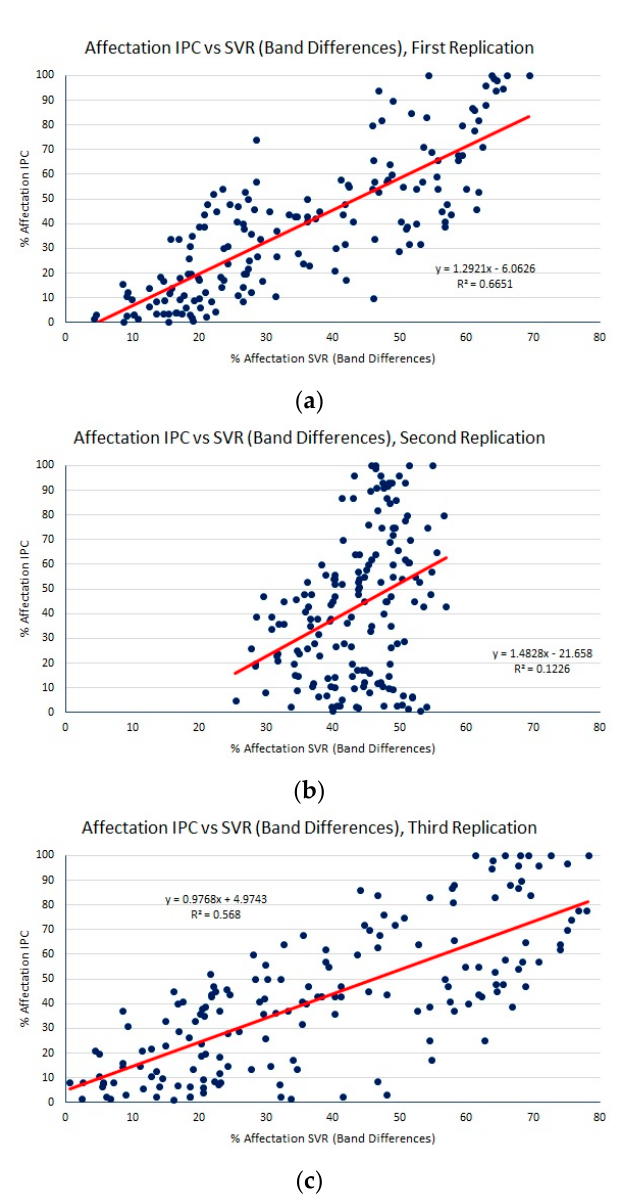
Figure 8. Percentage of P. infestans affectation using IPC methodology vs. estimated percentage of affectation using MLP on the PCA dataset, for ( a ) first replication, MAE: 15.06, RMSE: 19.31, R 2 : 0.5304; ( b ) second replication, MAE: 16.95, RMSE: 22.03, R 2 : 0.5719; ( c ) third replication, MAE: 17.80, RMSE: 24.28, R 2 : 0.3276. PCA: principal components analysis.